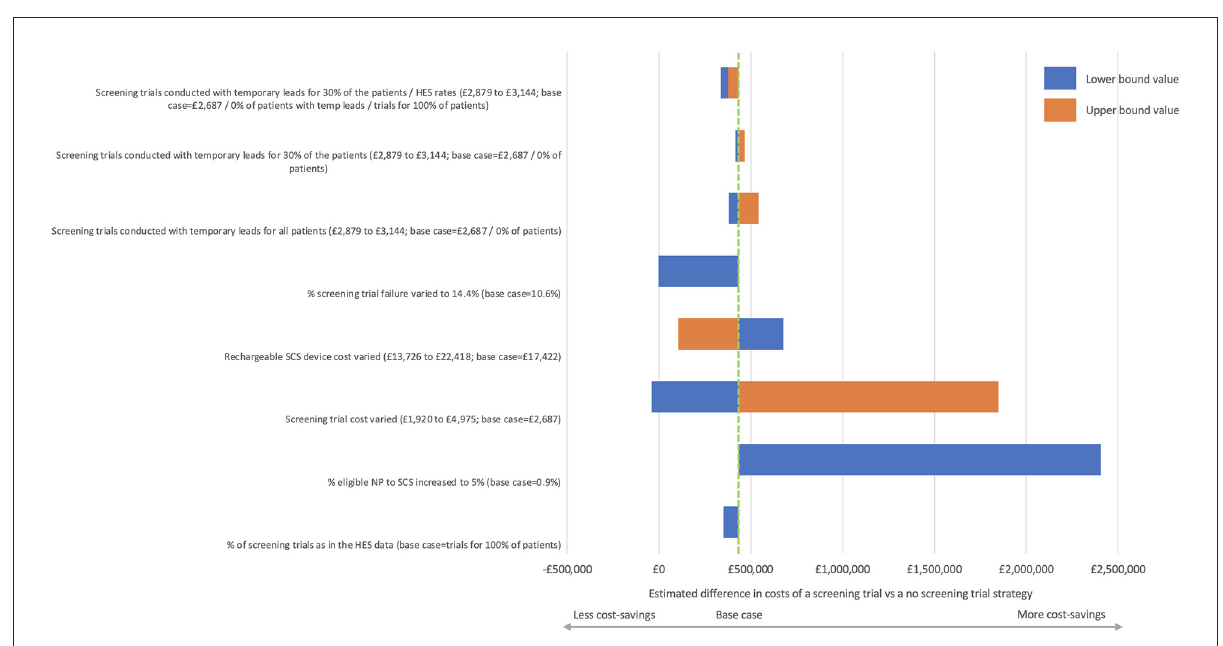
FIGURE1 Tornado diagram representing the deterministic sensitivity